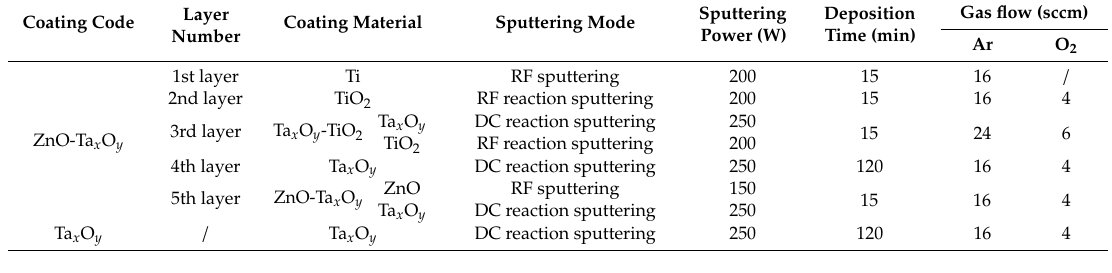
Table 1. Deposition parameters.